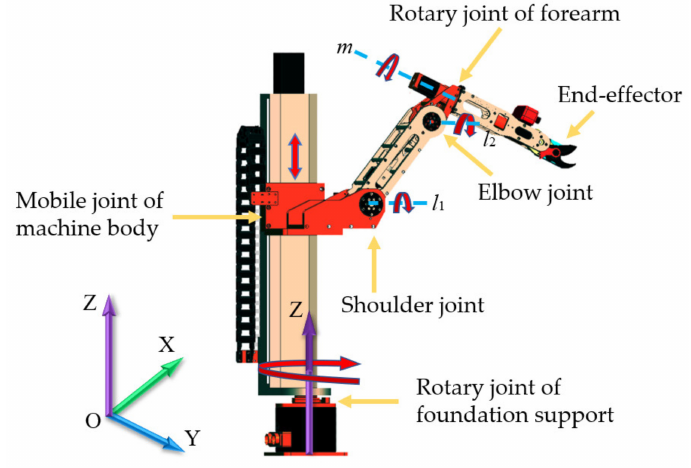
Figure 2. The structure and motion direction of each joint for the